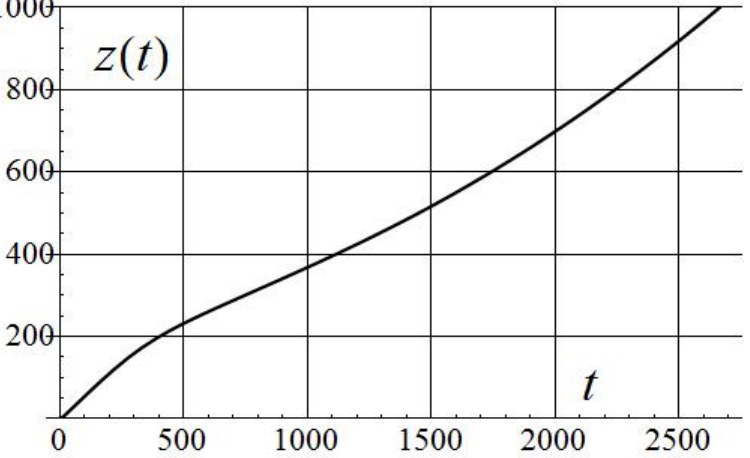
Figure 17. Submersion versus time: equatorial waters, steel cylinder l ∗ = l c = 2, C D = 0.82, η = 0.007.